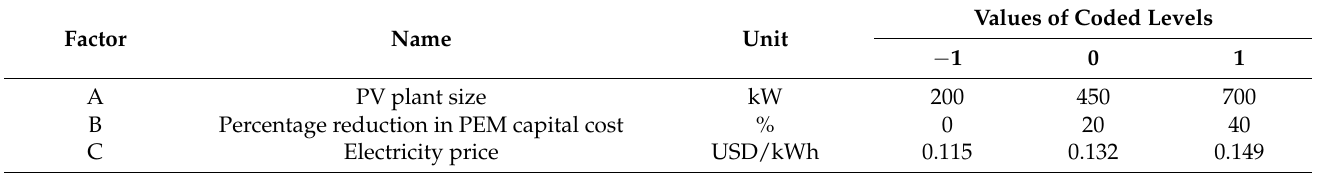
Table 6. Dependent variables and levels for the Face-Centered Central Composite